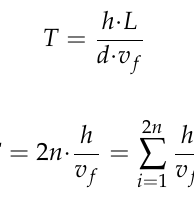
Table 1. Comparison between experimental and calculated values.